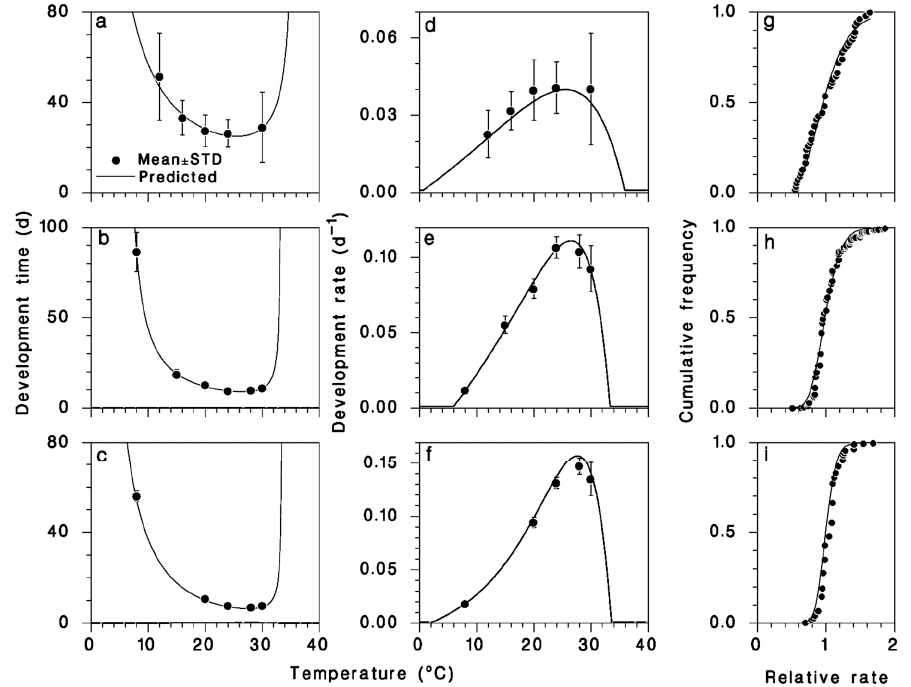
Figure 3. Relationship between A. interrupta development times ( a – c ), rates ( d – f ), and temperature. Points are means ± standard deviation. Distribution of individual values of ε compared to the lognormal ( g – i ).